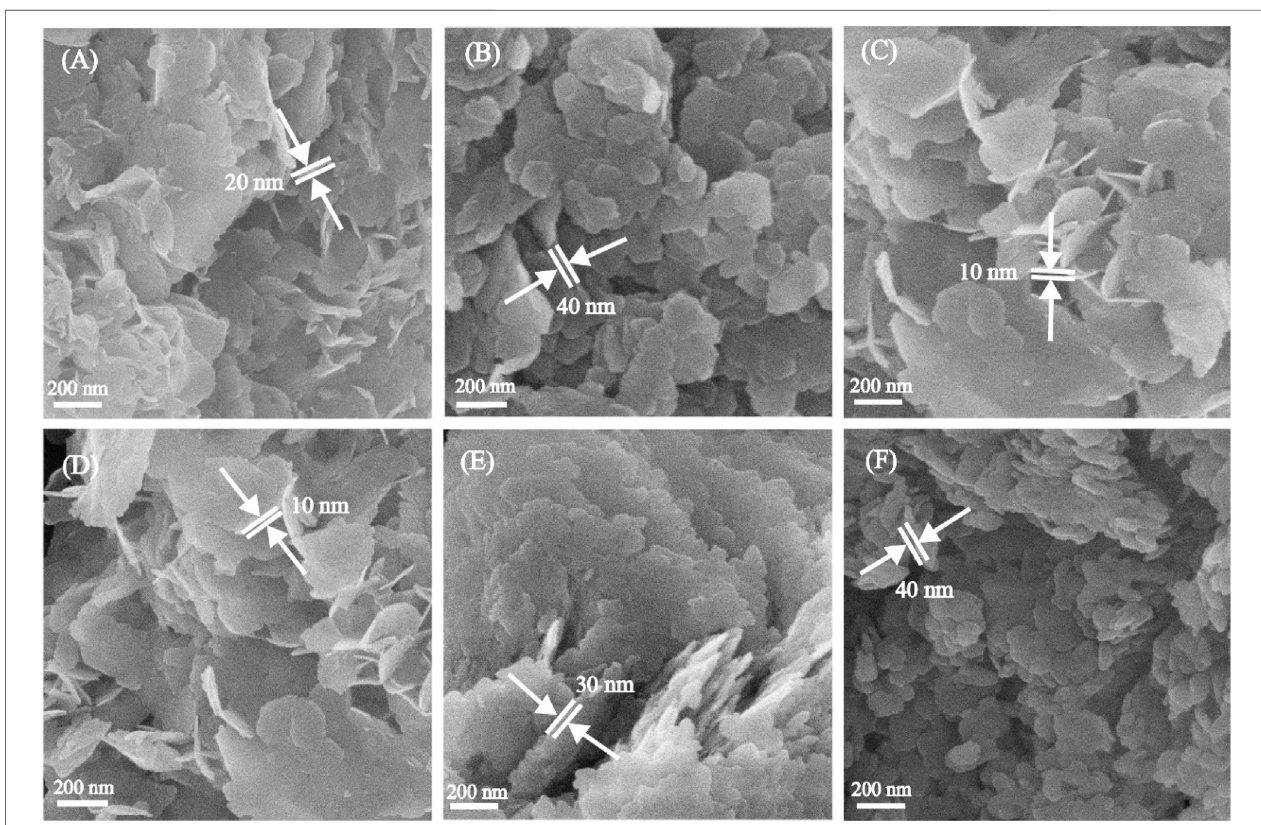
FIGURE2| SEMimagesofNiAl-LDHsprecursor (A) ,thealkaline-etchedsamplesin5 (B) ,10 (C,D) ,and15 (E) MKOHsolution,and β -Ni(OH) 2 samplepreparedby precipitation reaction (F) .